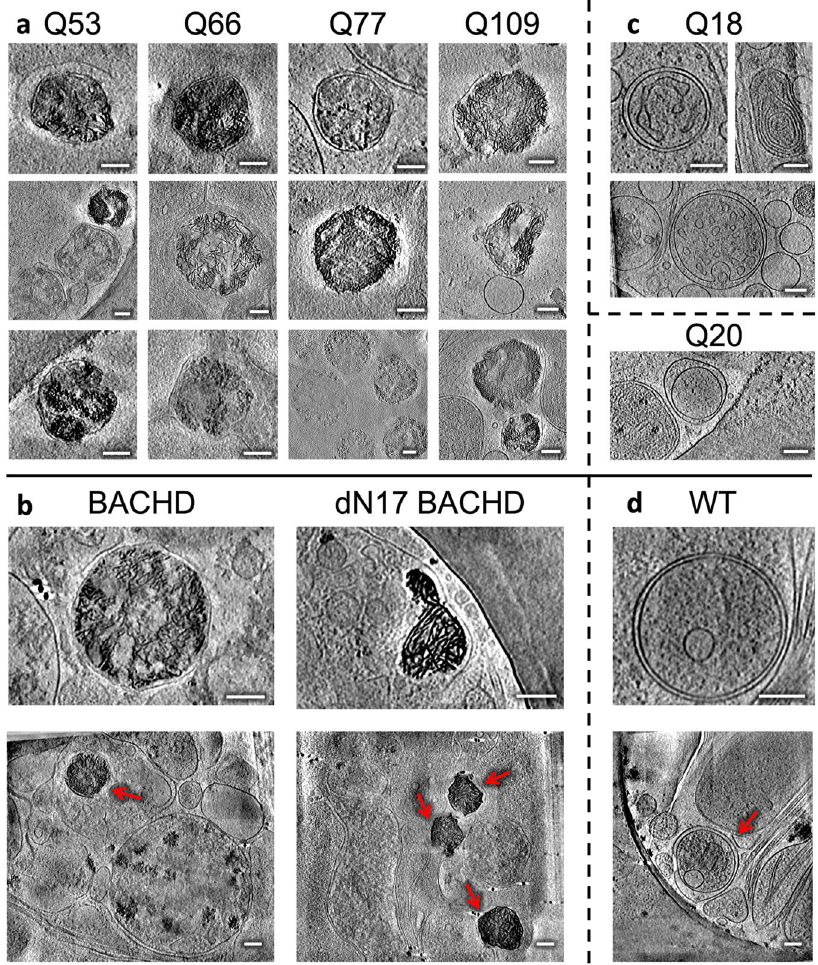
Fig.5|NeuritesinHDpatientiPSC-derivedandmousemodelprimaryneurons exhibit sheet aggregates within double membrane-bound organelles. Slices (~1.4nm thick) through selected regions of representative cryoET tomograms showing double membrane-bound compartments in neurites of a iPSC-neurons